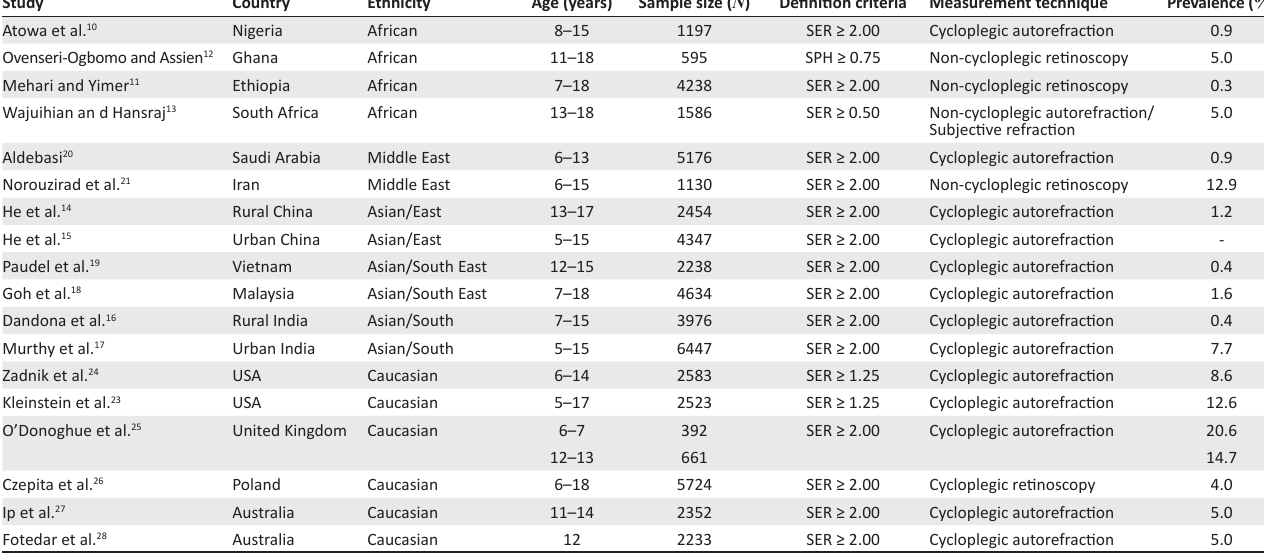
TABLE 1: Prevalence of hyperopia among school-age children in selected countries from various geographic regions.